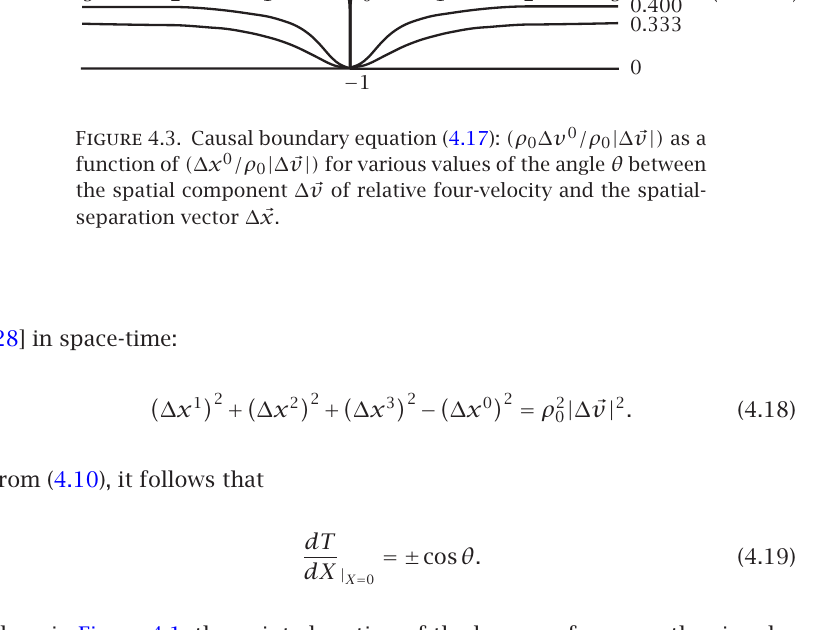
∆ v 0 /ρ | ∆ (cid:11)v | ) as a 0 0